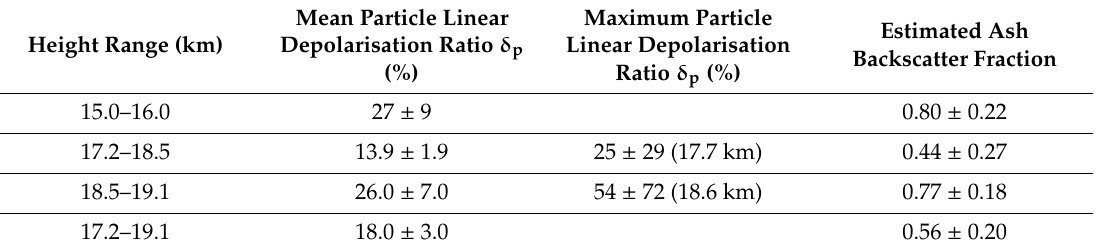
Table 5. Evaluations of particle depolarisation ratio for the Kingston measurements on 22 May using 100 m vertical resolution